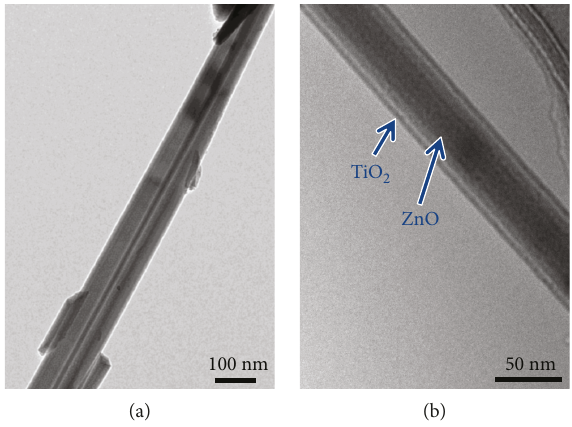
Figure 7: (a) TEM image of a lone ZnO nanowire, with hexagonal shape. (b) TEM image of a 1000-cycle TiO showing conformal coverage along the body of the